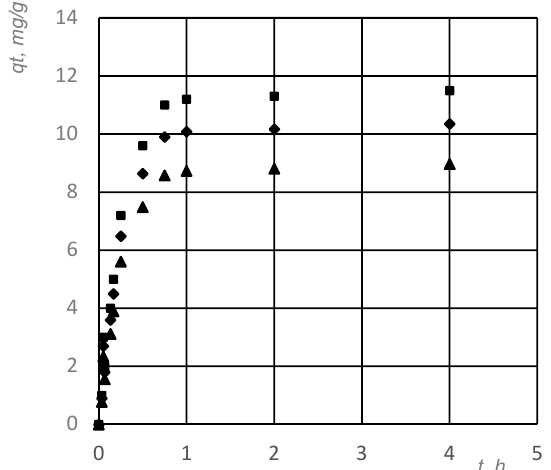
Figure 8. The influence of contact time on diazepam concentration uptake by mineral clay for dif- ferent sorbent particle sizes; T = 37.0 ± 0.1 °C; pH = 6.80 ± 0.05; C i = 18 mg/L; ■ D < 2 μ m; ◆ 4 μ m < D < 6 μ m; ▲ 8 μ m < D < 10 μ m; and S:L ratio = 1 g/L.